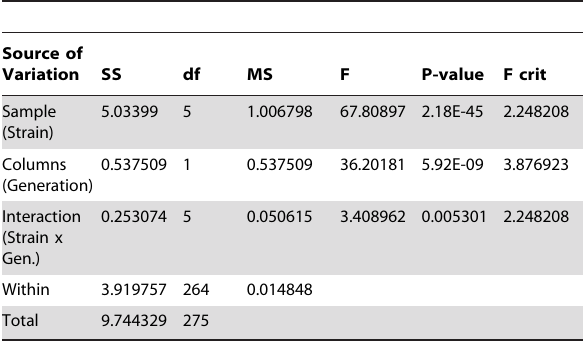
Table 2. ANOVA results for deletion level variation among strains and